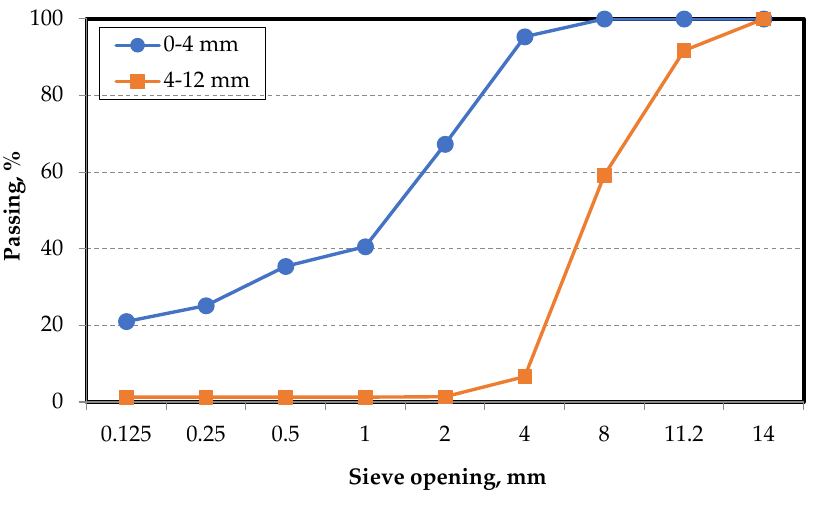
Figure 3. Particle size distribution of the